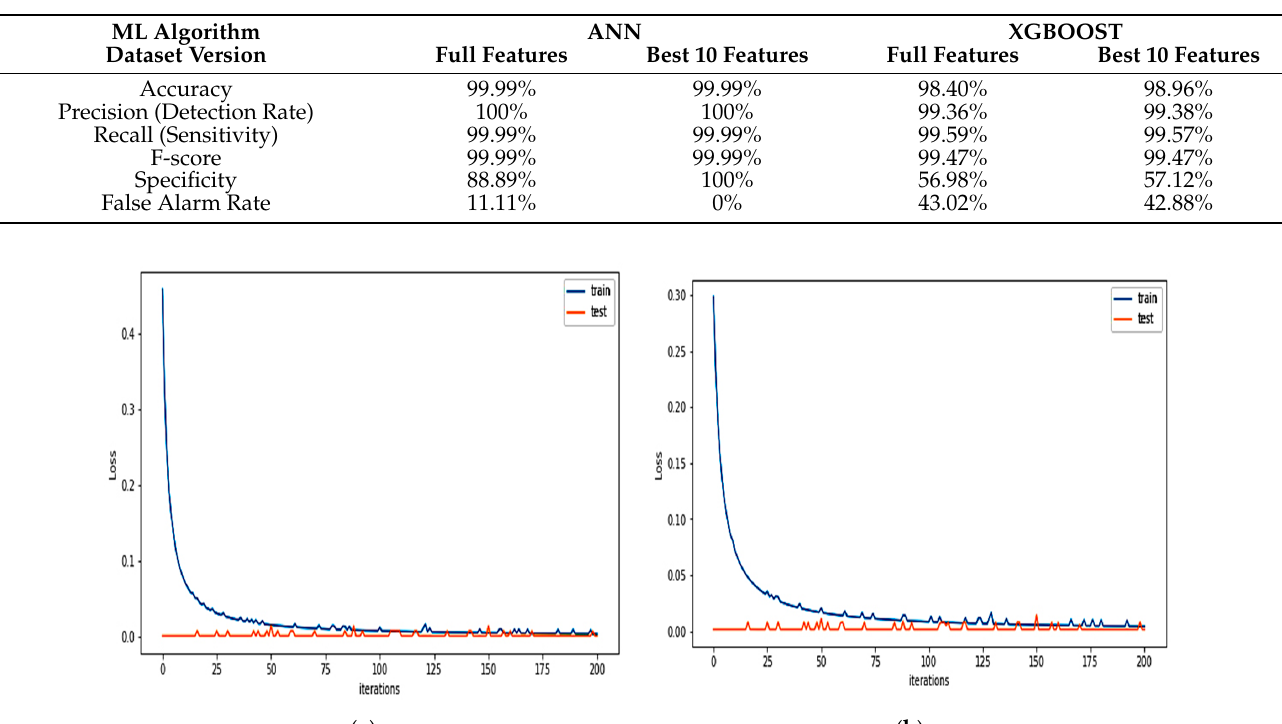
Figure 7. The average of training and testing losses of edge gateways (clients) of the proposed algorithm using: ( a ) BoT-IoT (full features); ( b ) BoT-IoT (best features).